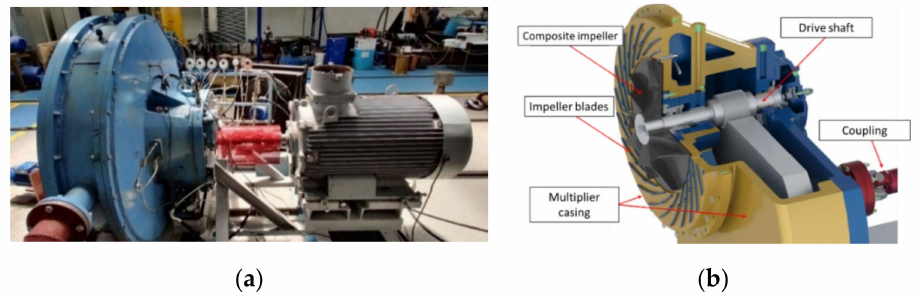
Figure 6. Experimental ( a ) compressor test bench and ( b ) schematic illustration of rotary assembly.